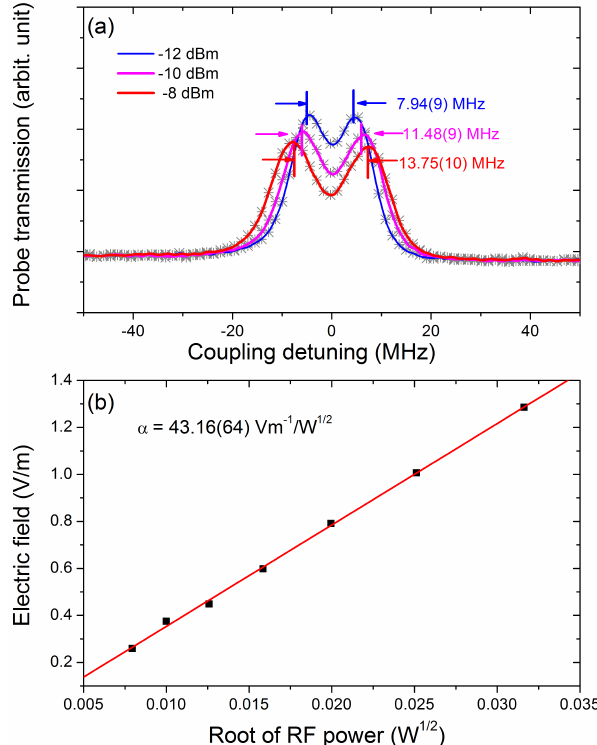
Figure 5. ( a ) Typical AT-splittings due to the RF induced interaction between the adjacent Rydberg states at different RF powers. ( b ) Measurements of the local RF E-field E L (black square) by EIT-AT √ P RF , and its linear fit (red line) by formula spectra versus the square root of the output power, √ E L = α P RF with parameter determined as α = 43.16 ( 64 ) Vm − 1 /W 1/2